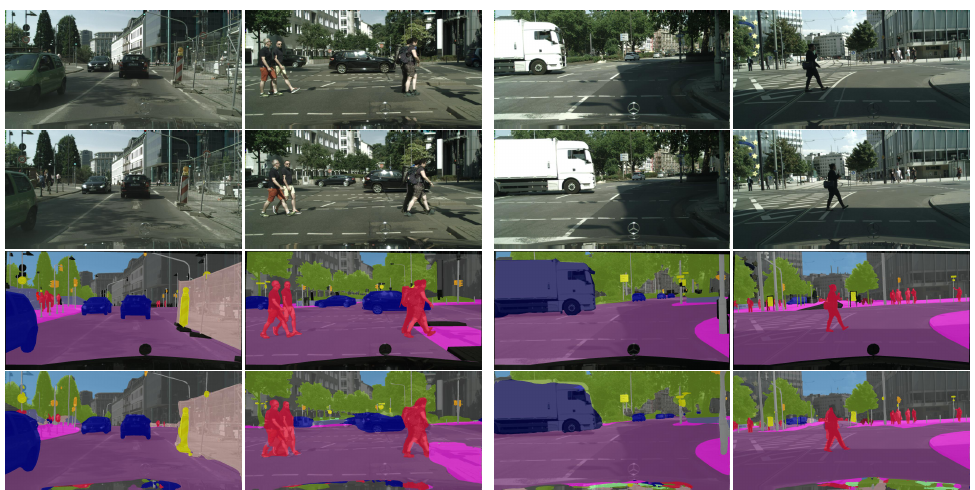
Figure 4. Two qualitative examples of short-term and two of mid-term forecasting on Cityscapes val. The rows show: the last observed frame, future frame (unobserved), ground truth, and our